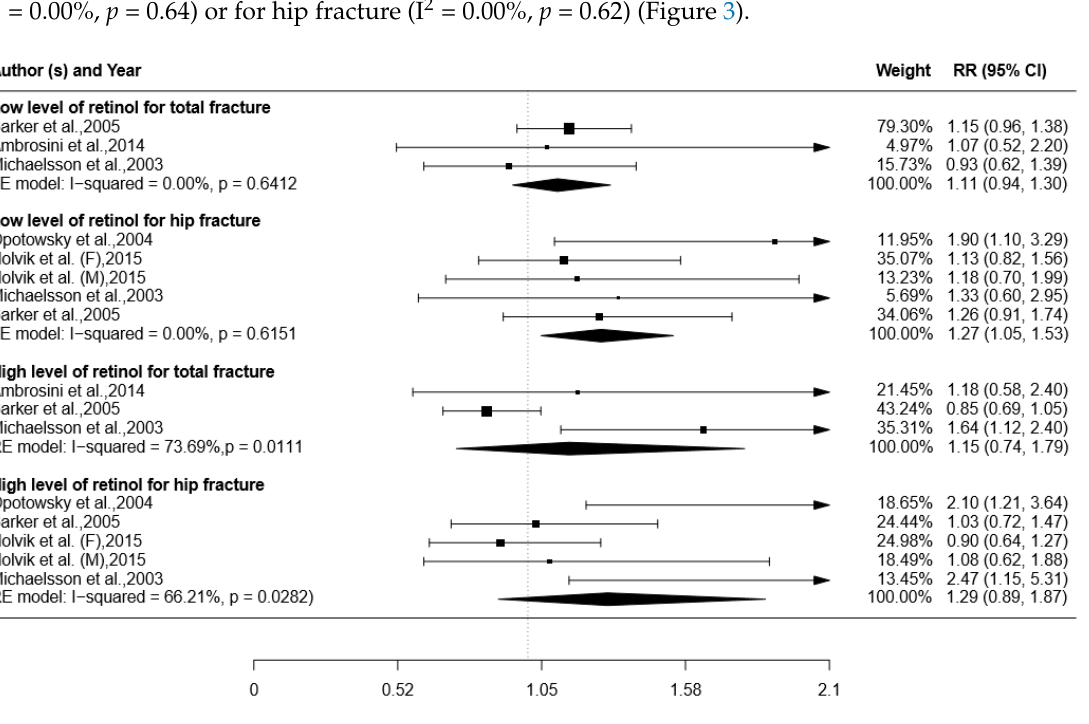
Figure 3. Association between blood level of retinol and risk of total or hip fracture. Boxes represent RR for each individual study; horizontal lines represent 95% CI; arrows indicate CI larger than 2.1; rhombus represent the combined RR with 95% CI.